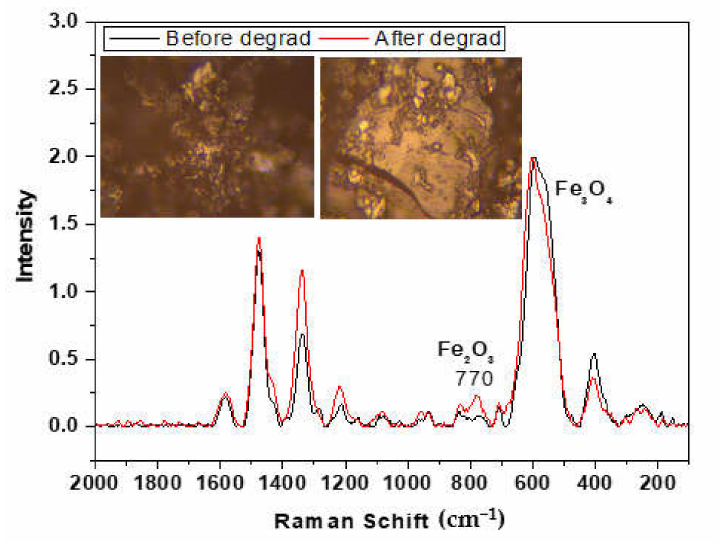
Figure 6. Raman spectra of MIONPs before and after AR 1 degradation.